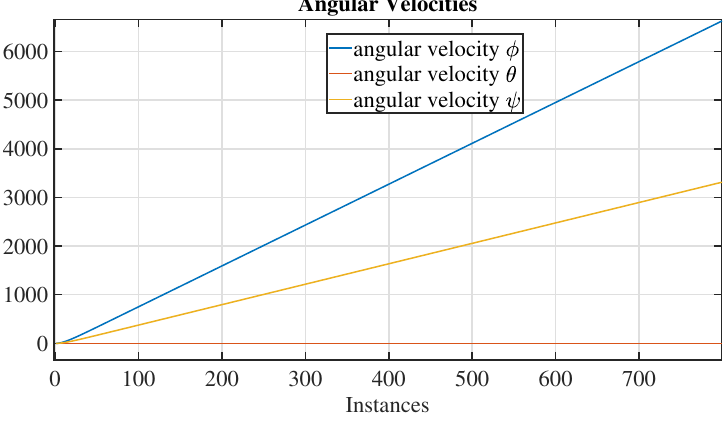
Figure 5. Angular velocities φ , θ , ψ